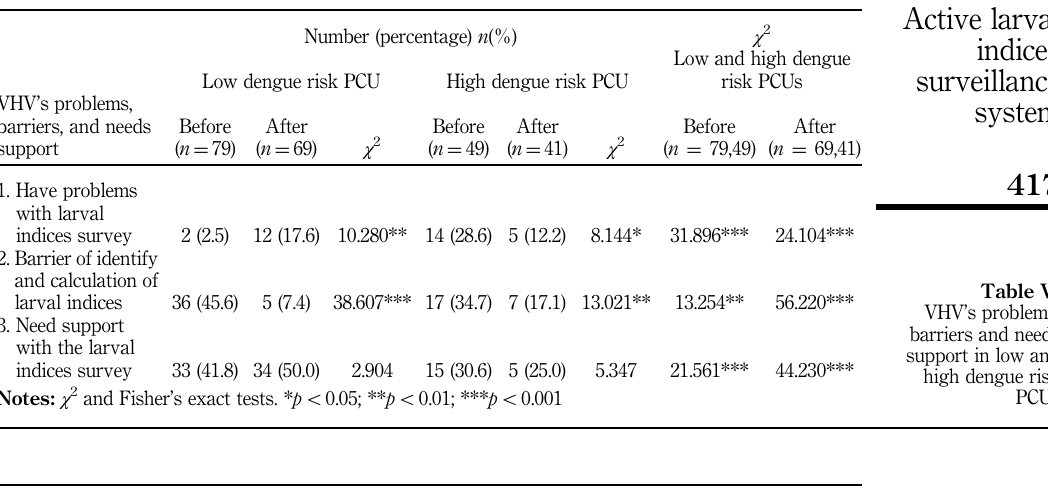
Table VI. Larval indices level of before and after development